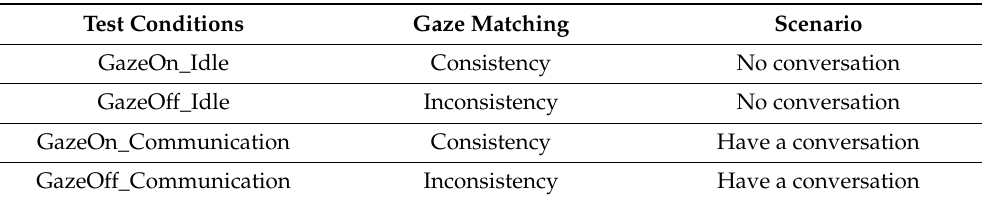
Table 1. The four conditions for experiments: the configured factors consisted of gaze alignment (gaze alignment on or off) and interaction scenario types (idle vs. communication).